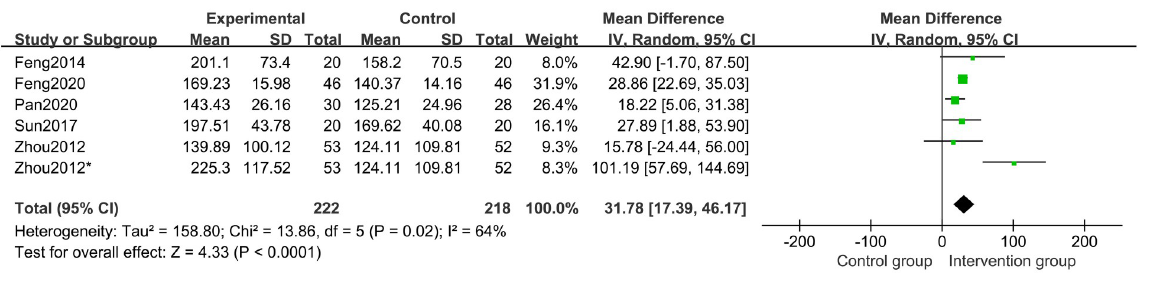
Fig 9. Forest plot of IGF-1